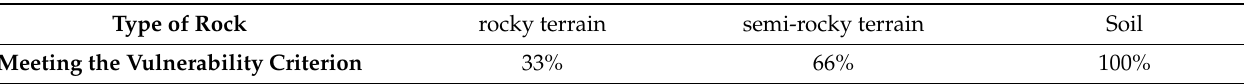
Table 12. Type of